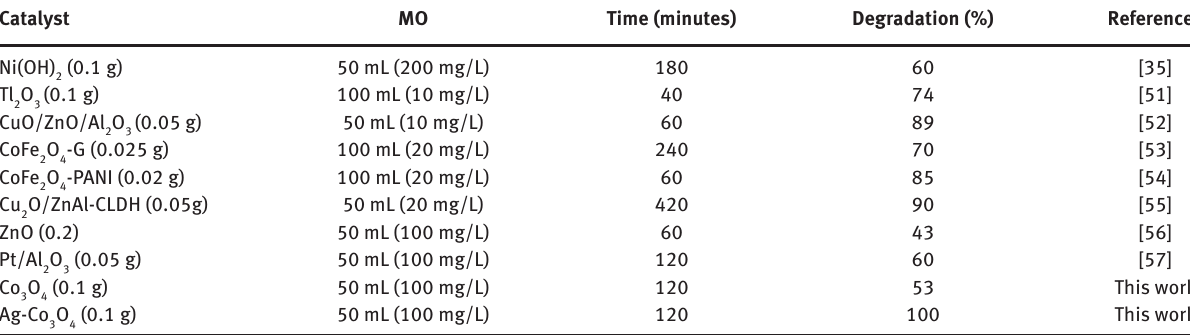
Figure 8: Comparison of photo catalytic activity of Co Ag-Co O (b) in terms of TON and TOF. 3 4